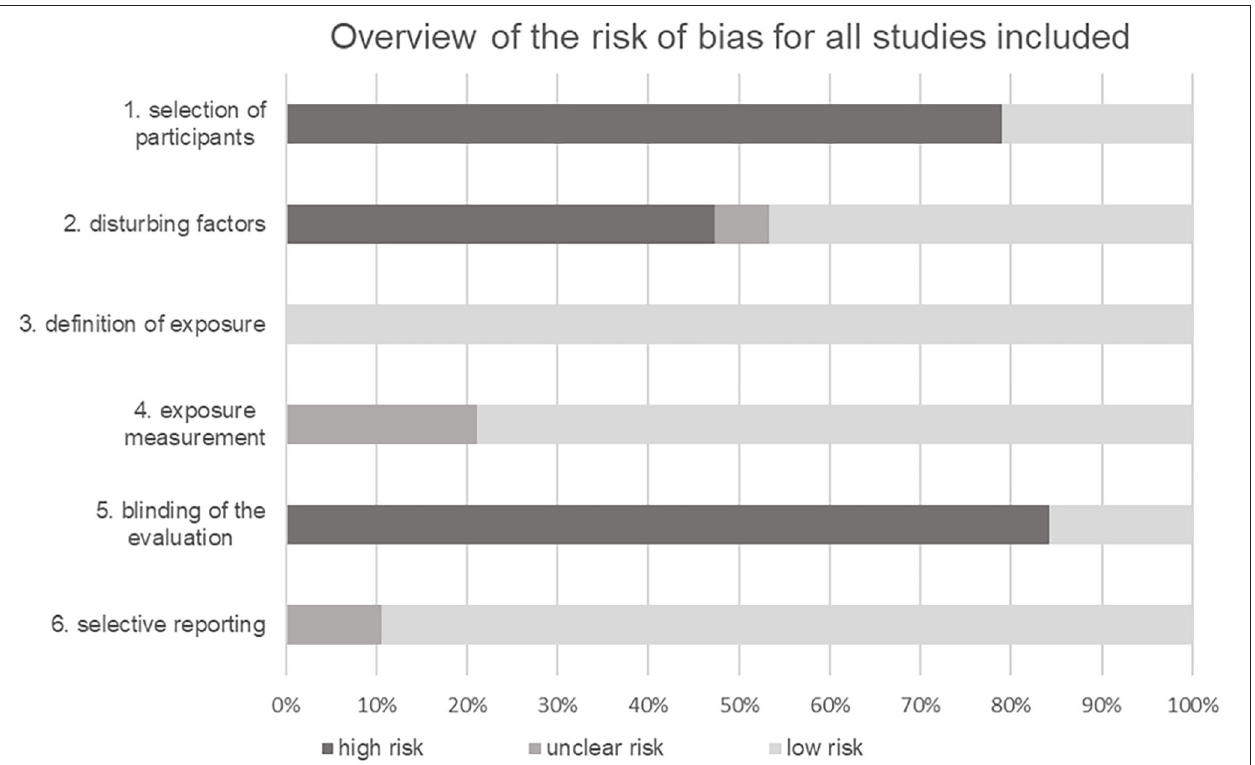
FIGURE 2 | Overview of the risk of bias for all studies in the categories of quality assessment.